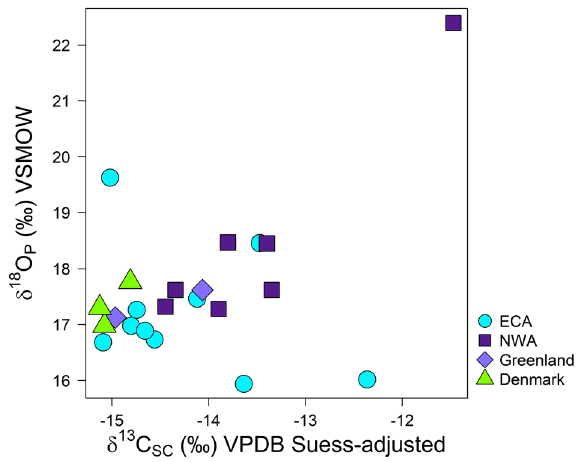
Figure 2. Biplot of dentine δ 18 O P versus Suess-adjusted δ 13 C SC values of teeth from eastern Canadian Arctic (ECA; turquoise circles) and Northwest Atlantic (NWA; purple squares) killer whales relative to bone values of killer whales from Greenland (light purple diamonds) and Denmark (green triangles). The range of δ 18 O P indicates considerable spatial separation. This result reflects latitudinal gradients in the North Atlantic, suggesting considerable spatial structuring among killer whales in both the ECA and NWA. Although dietary influences on δ 13 C confound direct interpretations within a spatial context, the range in δ 13 C SC values exceeds that expected due to dietary differences alone. The δ 13 C SC were adjusted by − 0.023‰ year −1 up to the year 2013 (the most recent sample) to account for temporal bias due to baseline shifts (Suess effect 42,43 ) in North Atlantic δ 13 C over the timespan of collected specimens (see Figure S2).